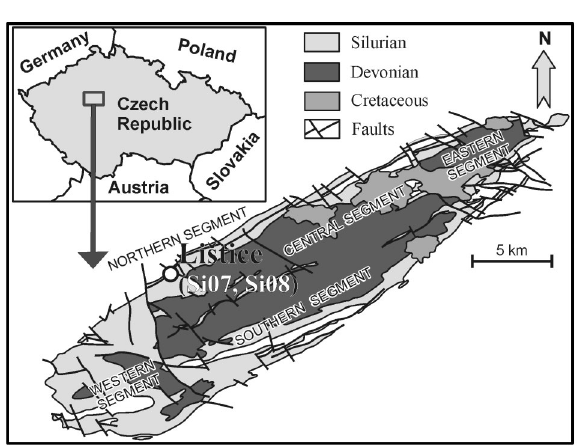
Fig. 1. Geological map of the Prague Basin (after K ř (cid:237)(cid:158) 1998). Li(cid:154)tice is marked by a white